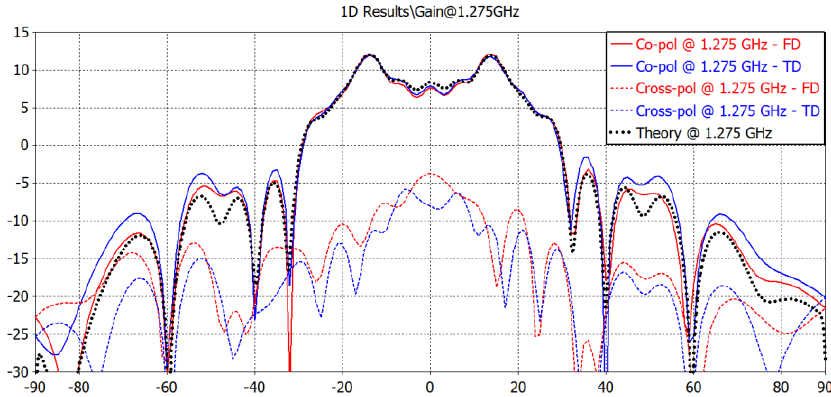
Figure 15. Design 2 – 16-element patch array: simulated gain at 1.275 GHz.